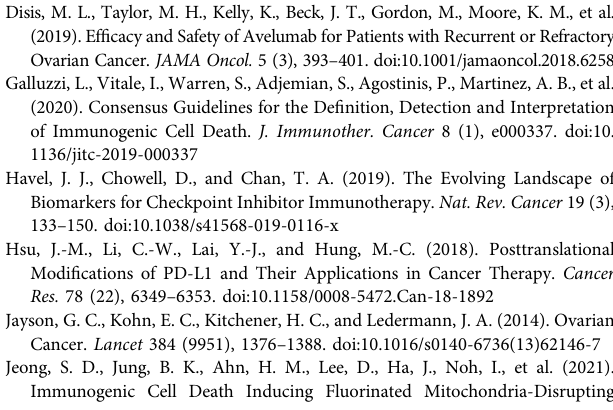
Supplementary Figure S1 | Prognostic analysis of immune checkpoints in ovarian cancer. (A – C) Different pathological stages analysis of PD-1 (A) , PD-L1 (B) and CTLA-4 (C) in ovarian cancer. Differential expression of log-scaling in different pathological stages was assessed by log2(TPM+1), and a Pr( > F) < 0.05 was recognized as statistically signi fi cant. (D) Correlation analysis of BRCA1 and PD- 1 in ovarian cancer. (E) Correlation analysis of BRCA1 and PD-L1 in ovarian cancer. (F) Correlation analysis of BRCA1 and CTLA-4 in ovarian cancer. (G) Correlation analysis of BRCA2 and PD-1 in ovarian cancer. (H) Correlation analysis of BRCA2 and PD-L1 in ovarian cancer. (I) Correlation analysis of BRCA2 and CTLA-4 in ovarian cancer. GEPIA generates the pair-wise gene expression correlations of two genes, or between one gene and several signatures in ovarian cancer (TCGA tumor) using Spearman method. The detailed p -value and R were individually presented as indicated in each panel. The statically signi fi cant difference was considered when a p -value is < 0.05. (J) Pathological Correlation of Immune Checkpoints. Supplementary Figure S2 | Expression of XBP1 in multiple human cancers and paired normal tissues. GEPIA generates box plots with jitter (size = 0.5) for comparing XBP1 expression in multiple human cancers and paired normal tissues. (TCGA tumor versus TCGA normal + GTEx normal). T, tumor samples; N, normal samples. ACC, Adrenocortical carcinoma; BLCA, Bladder Urothelial Carcinoma; BRCA, Breast invasive carcinoma; CESC, Cervical squamous cell carcinoma and endocervical adenocarcinoma; CHOL, Cholangiocarcinoma; COAD, Colon adenocarcinoma; DLBC, Lymphoid Neoplasm Diffuse Large B-cell Lymphoma; ESCA, Esophageal carcinoma; GBM, Glioblastoma multiforme; HNSC, Head and Neck squamous cell carcinoma; KICH, Kidney Chromophobe; KIRC, Kidneyrenalclearcellcarcinoma;KIRP,Kidneyrenalpapillarycellcarcinoma;LAML, Acute Myeloid Leukemia; LGG, Brain Lower Grade Glioma; LIHC, Liver hepatocellular carcinoma; LUAD, Lung adenocarcinoma; LUSC, Lung squamous cell carcinoma; MESO, Mesothelioma; OV, Ovarian serous cystadenocarcinoma; PAAD, Pancreatic adenocarcinoma; PAAD, Pancreatic adenocarcinoma; PCPG, Pheochromocytoma and Paraganglioma; PRAD, Prostate adenocarcinoma; READ, Rectum adenocarcinoma; SARC Sarcoma; SKCM, Skin Cutaneous